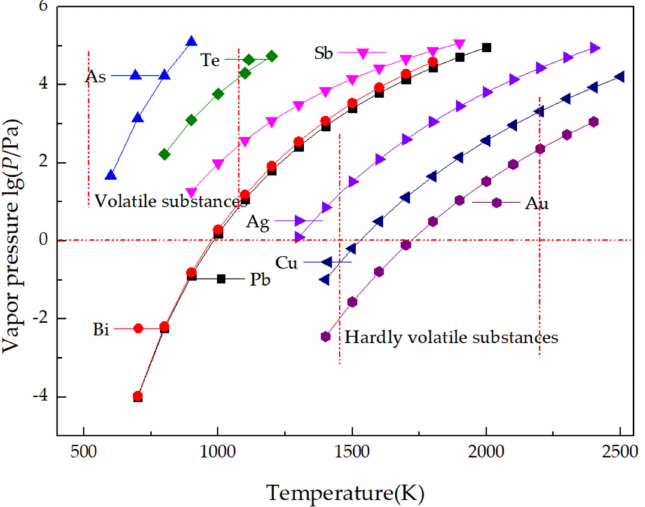
Figure 2. Relationship between the saturated vapor pressure and temperature of each pure substance in